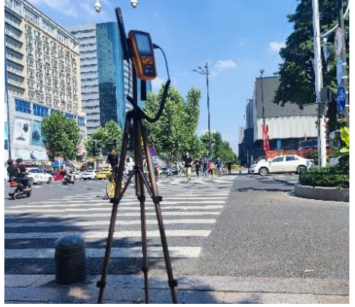
Figure 8. Photo of field measurement. Table 3. Measurement results and standard deviation of